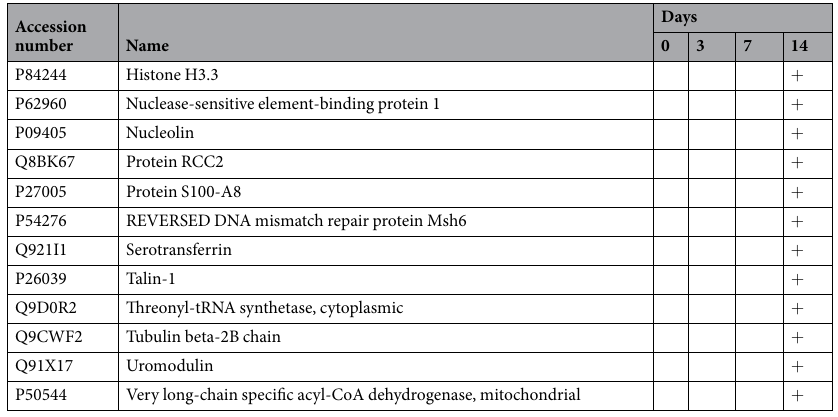
Table 2. Identified possible substrates for TG2 using pepT26. Kidney extract on each indicated day after UUO surgery was incubated with biotinylated pepT26. The newly identified possible substrates in each indicated day were demonstrated as “ + ” compared to control sample (Day 0). The underlined possible substrates indicate overlapped substrates identified as both peptide (pepK5 and pepT26)-incorporated